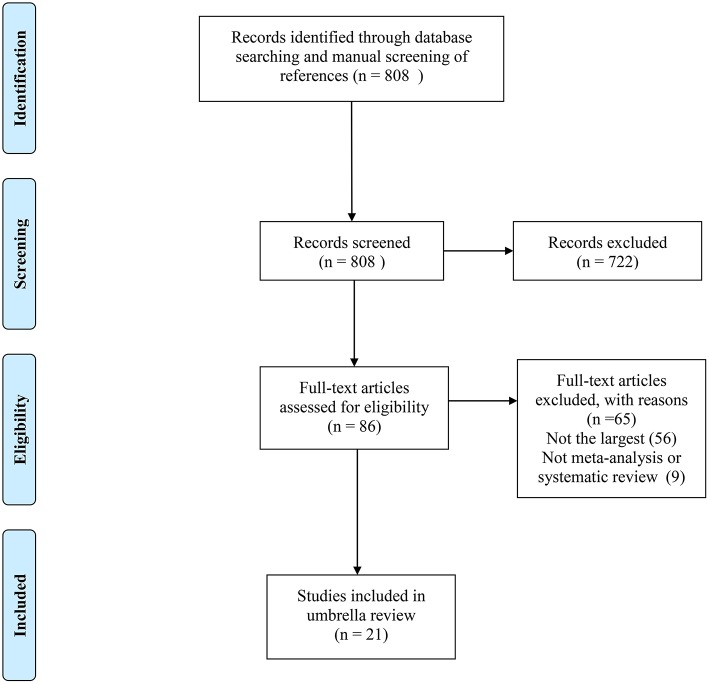
The flow diagram of study selection.